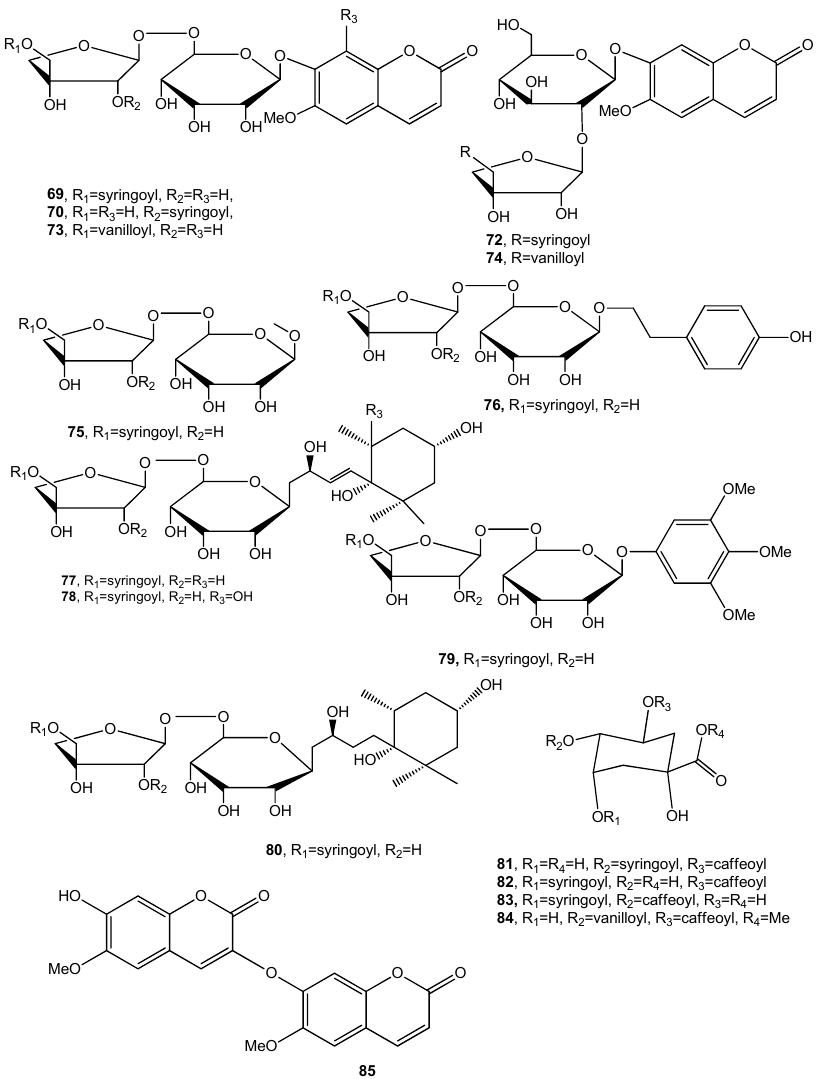
Figure 6 . The structures of compounds 69 – 85 . NTCT and NCCT, 1,7-bis(4-hydroxyphenyl)heptane-3,5-diol and 6-hydroxy-2,4,7- trimethoxyphenanthrene were isolated from the fresh tuberous rhizomes of Chinese yam ( Dioscorea opposita Thunb.) (Dioscoreaceae) [64]. This plant has a noteworthy interest in agriculture, food and pharmaceutical fields [65,66]. NTCT, NTCT and the hepatanediol derivative were isolated for the first time from D. opposita . The inhibitory activities of crude extracts as well as those of purified constituents were evaluated against yeast α - glucosidase to search for the active principles for treatment of diabetes. NTCT, the hep- tanediol and the phenanthrene derivative showed a significant activity with IC 50 = 0.40, 0.38 and 0.77 μ M, respectively, while NCCT was inactive suggesting that the stereochem- istry of the double bond of this alkylamide is a structural feature important for the activity [64]. NTFT, NTCT and 3 ′ methoxy-NTFT and kaempferol ( 86 and 8 7, Figure 7) were iso- lated from Welsh onion ( Allium fistulosum L.) (Amaryllidaceae) organic extracts [67]. A. fistulosum L. is a perennial herb that is classified as an Allium species, which is a popular flavoring vegetable in China, Japan and Korea [68]. This plant is widely cultivated in southern areas of Korea and is traditionally used for salads and cooking. In the same coun- try, its roots and trunks were used in traditional folk medicine for the treatment of febrile disease, headache, abdominal pain, diarrhea and habitual abortion [69]. Successive